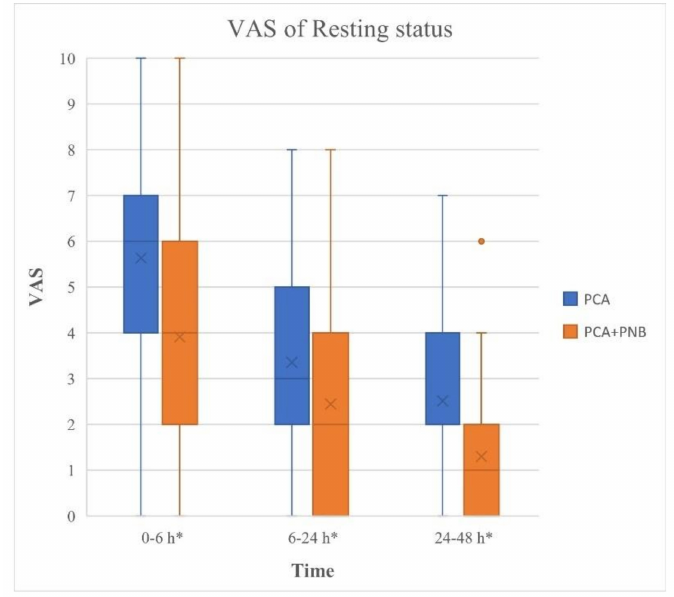
Figure 2. VAS during rest for patients from the PCA and PCA + PNB groups who underwent THA. * Statistically significant difference between two groups ( p < 0.05). PCA: patient-controlled analgesia; PNB: peripheral nerve block; THA: total hip arthroplasty; VAS: visual analogue scale.